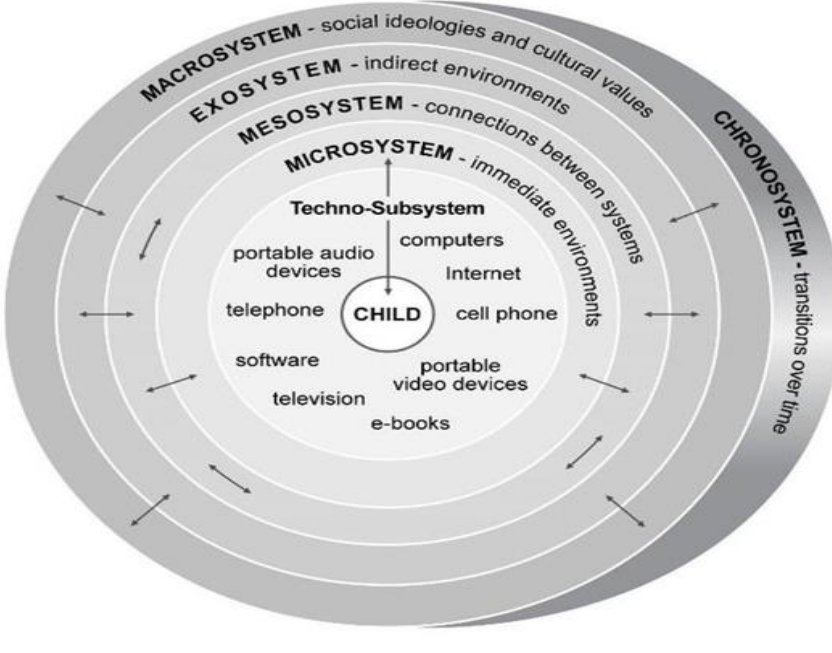
Figure 1. The Ecological Techno-Subsystem (Johnson and Puplampu 2008: